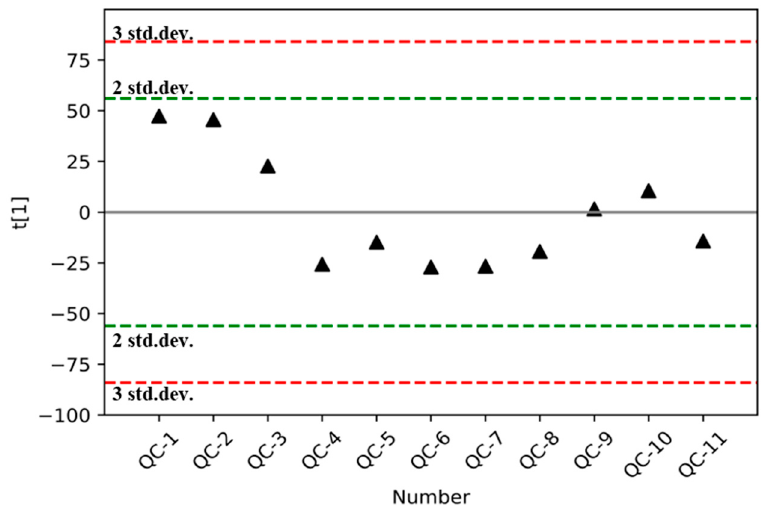
Figure 7. Scatter plot of the first principal component of eleven QC samples (triangles). This analysis showed that the standard deviation of QC samples was within ± 2 SD, indicating that the results was reliable.